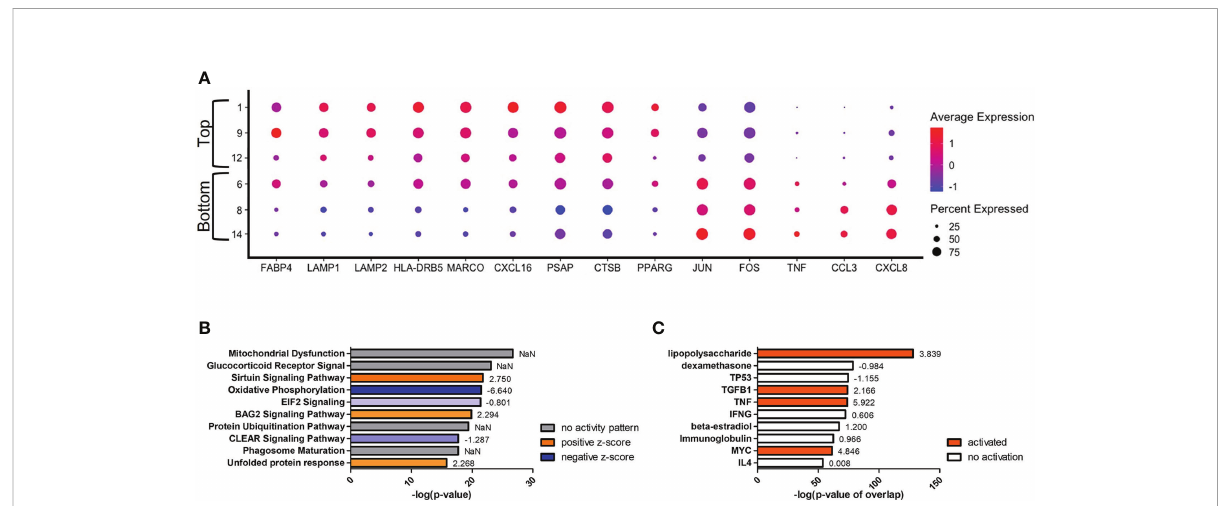
FIGURE 6 Transcriptome Evolution to Active State in Clusters #8/14. Processed human BAL cells were enriched for phagocytic APCs and incubated with C neoformans strain H99 for 2h and processed for scRNA-seq. Genes differentially expressed in clusters #8/14 when compared to clusters #1/9/ 12 were analyzed by IPA. (A) Differential expression of select genes in clusters #6/8/14 (bottom) and #1/9/12 (top). Top 10 signi fi cantly regulated canonical pathways (B) and predicted upstream regulators (C) as ordered by p -value or p -value of overlap. To the right of each bar is the statistical z-score for each pathway or upstream regulator with positive and negative being increased and decreased, respectively (NaN = not a number, no activity pattern). Data shown are combined cells from three individual experiments